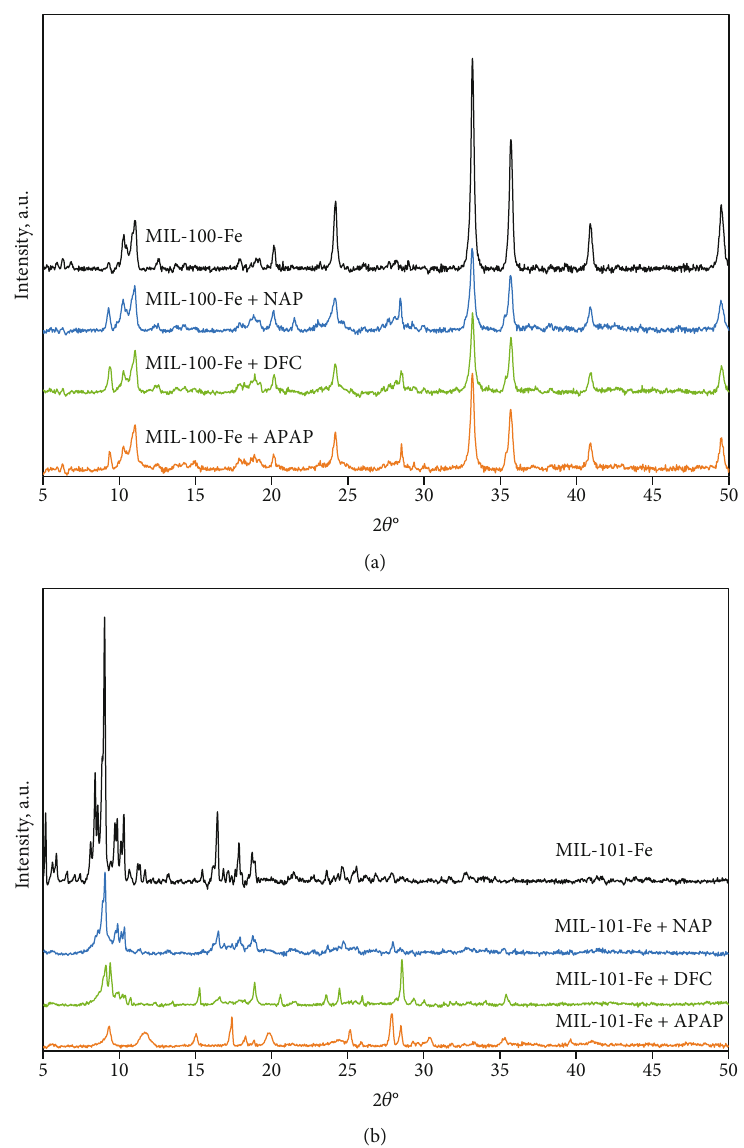
Figure 1: X-ray di ff raction patterns of (a) MIL-100-Fe and (b) MIL-101-Fe before and after the adsorption of naproxen (NAP), diclofenac (DFC), and acetaminophen (APAP)